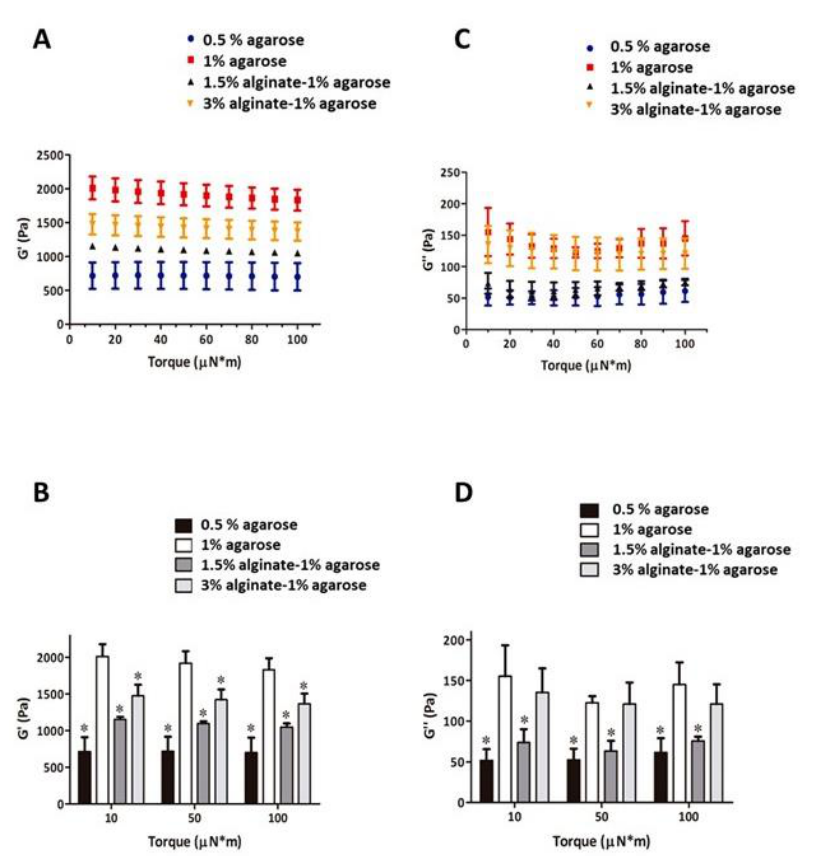
Figure 1. Mechanical test of hydrogels. Hydrogels of 0.5% agarose, 1% agarose, 1.5% alginate-1% agarose, and 3% alginate-1% agarose were manufactured and the storage modulus (G', A , B ) and loss modulus (G'', C , D ) were calculated at RT, using a torque of 50 µN*m. The results represented are means ± SD of n = 10 different experiments.